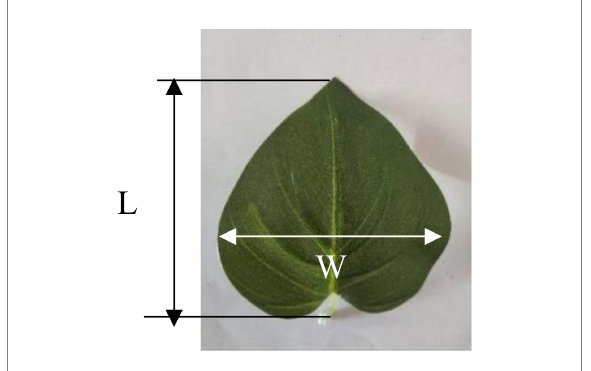
FIGURE 4 Sample leaf of simulated broad-leaved